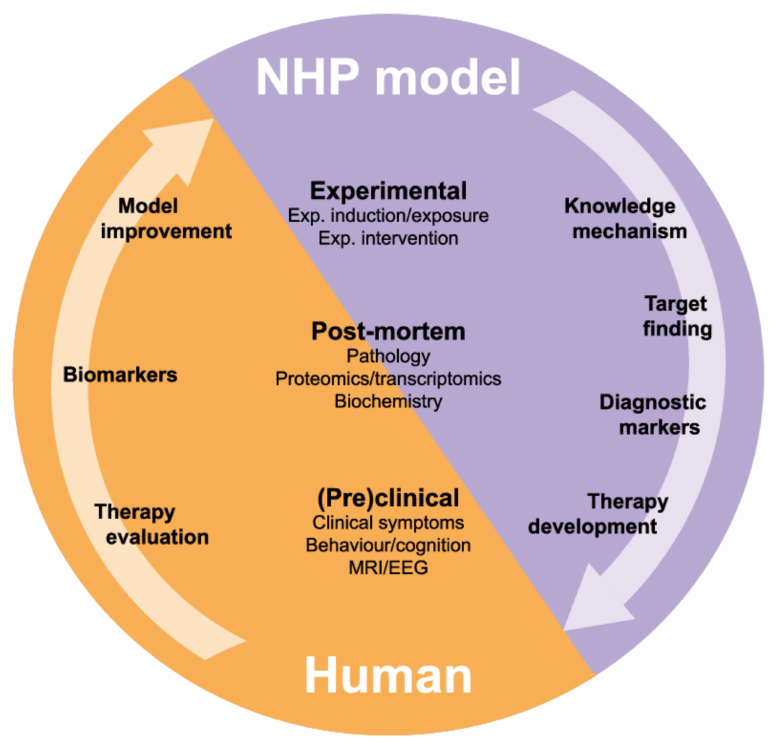
Figure 3. Translational model for mechanistic research and development of therapeutic interventions. Overlapping (pre)clinical and post-mortem markers between human and nonhuman primate (NHP) models increase the extrapolation of the results. The correlation between the experimental (invasive) interventions and the invasive/post-mortem parameters from NHP studies will provide relevant knowledge about the underlying mechanism and will help to find new targets for